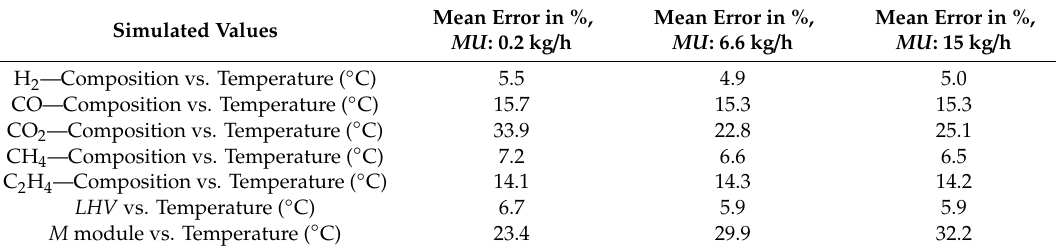
Table A2. Comparison of experimental and simulated data with method of mean